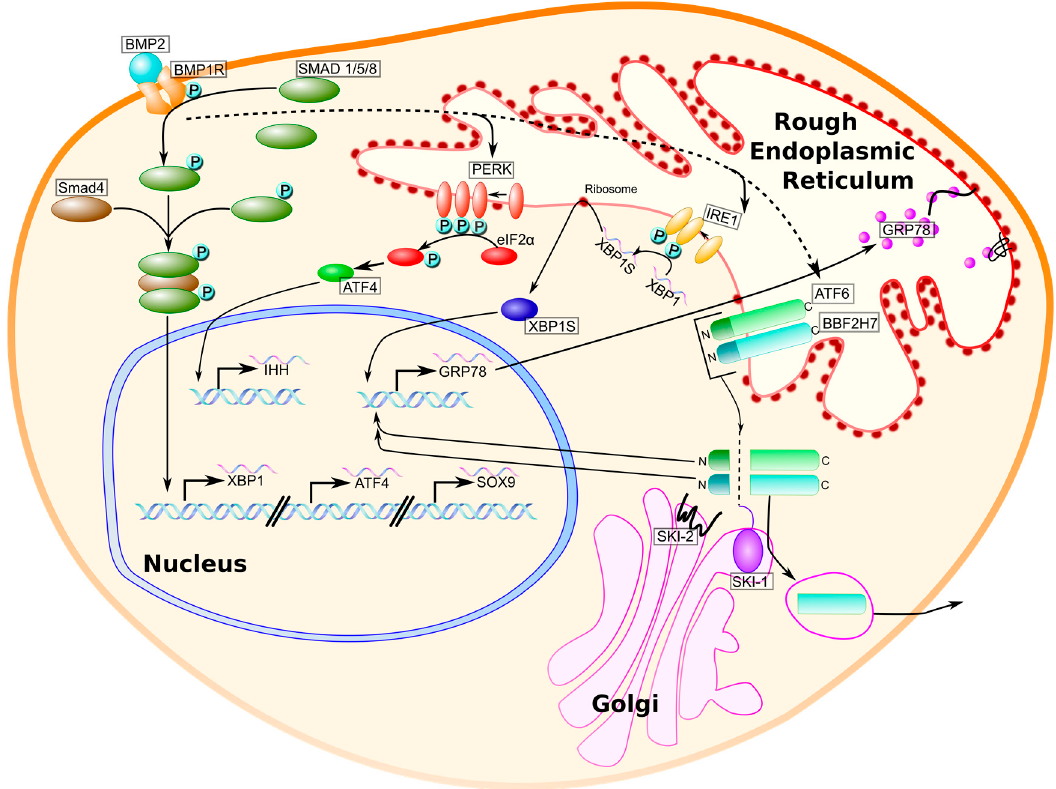
Figure 1. BMP-mediated induction of physiological unfolded protein response (UPR) signaling in chondrocytes. Bone morphogenetic protein 2 (BMP2) is an extracellular growth factor that enacts UPR activity in chondrocytes in two ways: (1) the binding of BMP2 to its receptor, BMP1R, results in Smad 1/5/8 phosphorylation and the association with a co-Smad, Smad4, to form a trimeric activator of UPR genes XBP1 , ATF4 , and the chondrogenesis regulator SOX9 (solid line); and (2) BMP2 increases the activity of the UPR transducers PKR-like endoplasmic reticulum kinase (PERK), inositol-requiring endonuclease 1 (IRE1), activating transcription factor 6 (ATF6) (dotted line), and BBF2H7, an ATF6 homolog expressed by chondrocytes. PERK phosphorylates eukaryotic translation initiation factor 2a (eiF2a) to halt general protein translation while promoting the translation of activating transcription factor 4 (ATF4) (translation not shown). IRE1 splices XBP1 mRNA to generate XBP1S mRNA, which is translated to yield the transcription factor XBP1S. ATF6 and BBF2H7 translocate to the Golgi, where they are cleaved by site-1 and site-2 proteases (SKI-1 and SKI-2) to generate N-termini that serve as transcription factors for chaperone proteins, such as glucose-regulated protein 78 kDa (GRP78). The upregulation of chaperone proteins enhances the folding capacity of the ER during chondrogenesis.